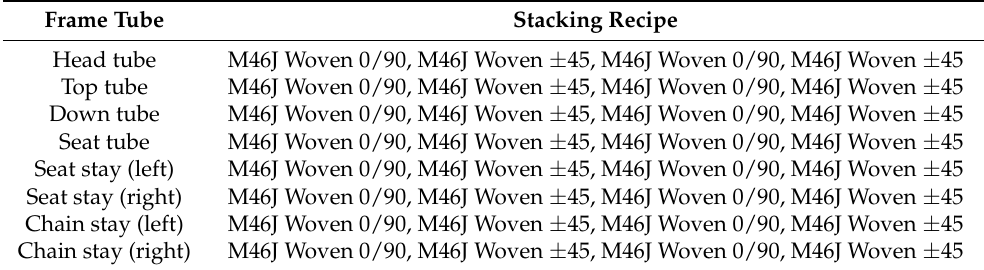
Table 2. Quasi-isotropic layup using M46J Woven fabric.